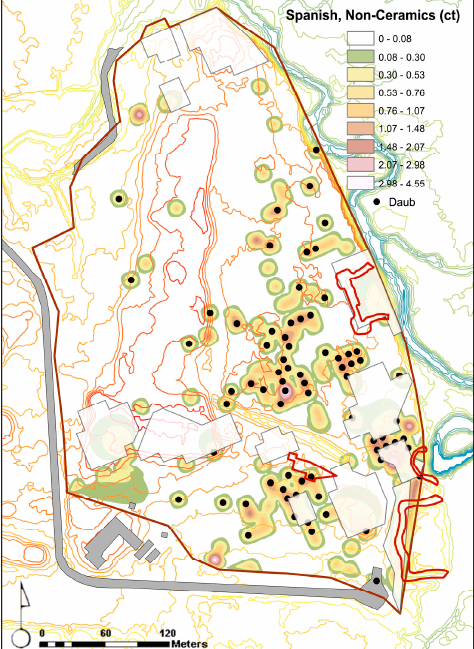
Figure 13. The distribution of Spanish period non-ceramic materials and the location of shovel tests yielding daub, likely of Spanish origin. Areas whited-out were not shovel tested. Contour spacing is 1 m. Contours are based on the LiDAR dataset and use the NAD 1983 and NAV 1988 horizontal and vertical datum, respectively.